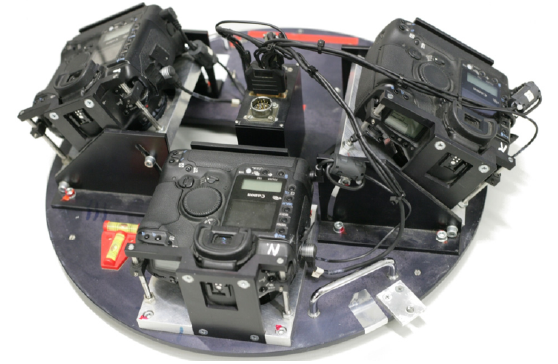
Figure 2. The 3K camera system.